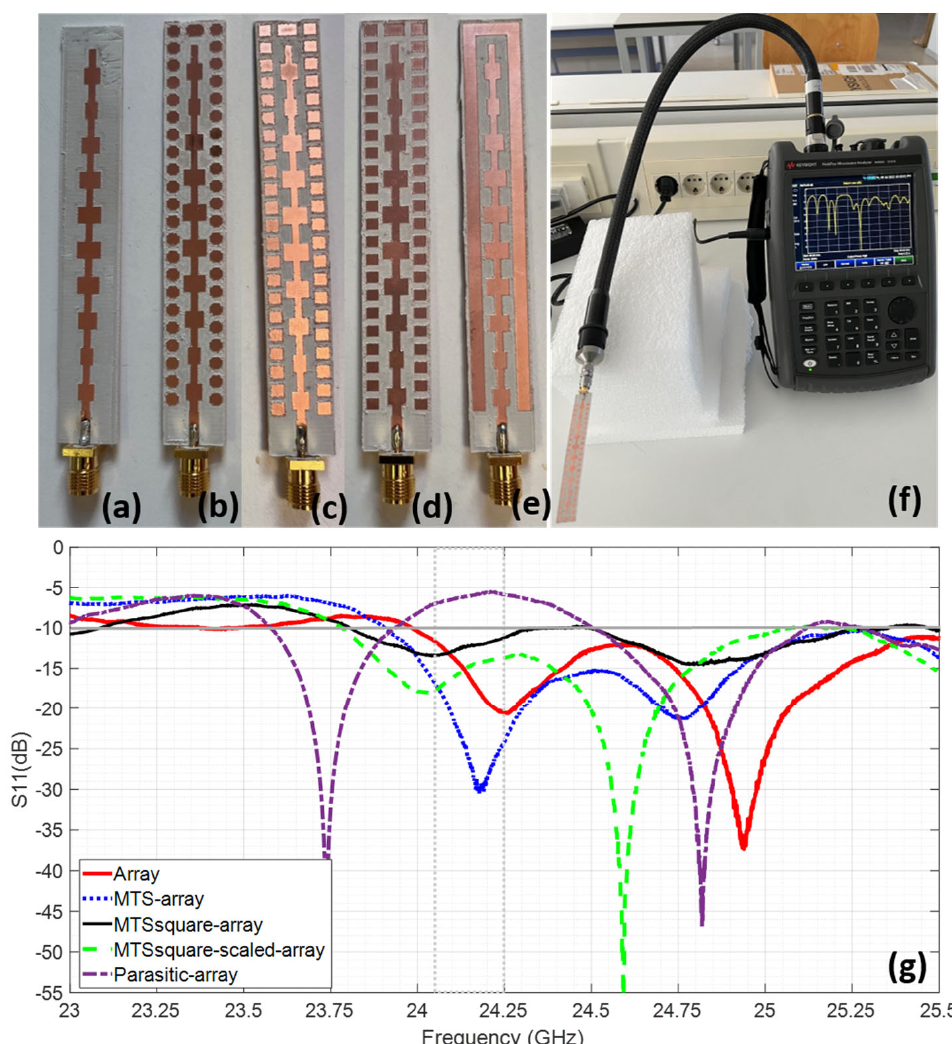
Figure 8. Fabricated prototypes of the antennas under analysis: ( a ) array, ( b ) MTS–array, ( c ) MTSsquare–array, ( d ) MTSsquare-scaled–array and ( e ) array–parasite; ( f ) measurement set-up for the reflection coefficient, S 11 (dB) and ( g ) measurement results for the reflection coefficient, S 11 (dB), of the fabricated